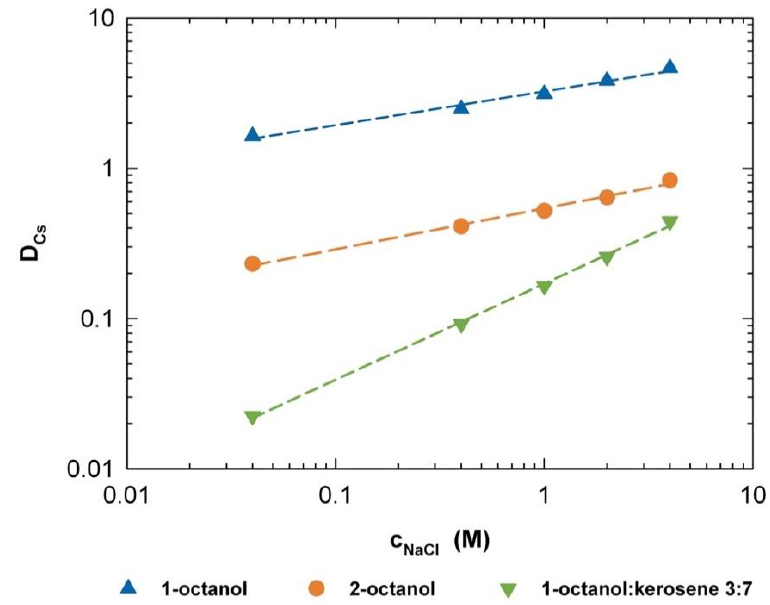
Figure 3. Cs + extraction as a function of NaCl concentration. Organic phase, 0.01 M BOBCalix in 1-octanol, 2-octanol, or 1-octanol/kerosene 3:7. Aqueous phase, NaCl + 0.001 M HCl + 137 Cs (10 kBq/mL).